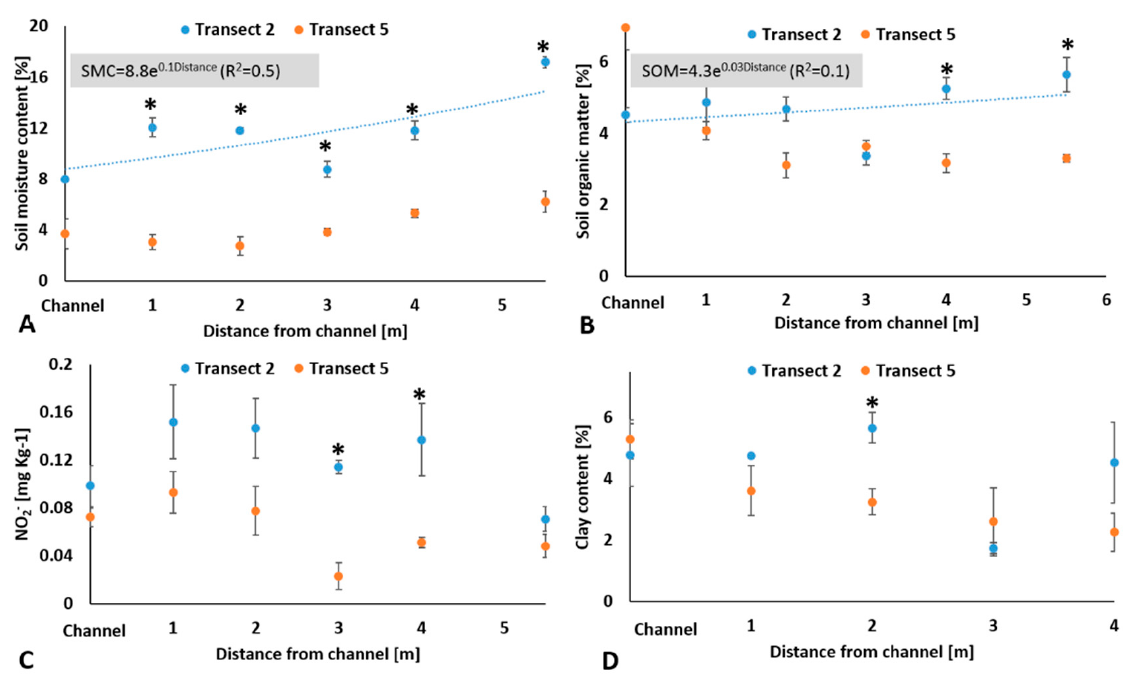
Figure 8. The influence of grazing over wadi slopes on soil properties. ( A ) Soil moisture content, ( B ) soil organic matter, ( C ) nitrite content (N-NO 2 − ), ( D ) clay content. Lines on columns/graph: mean ± SE, statistics: ANOVA (comparison of values located in the similar contour of transects), *—significant ( α = 0.1).